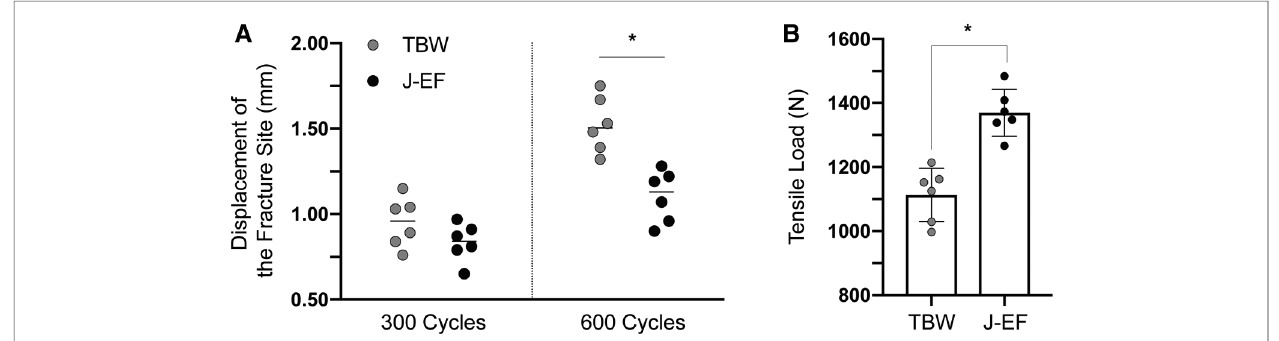
FIGURE 2 | Biomechanical properties of J-EF. Tensile strength of J-EF was tested using tension-band wiring (TBW) as the control. The tensile strength of the J-EF group was greater than that of the TBW group after running 600 cycles ( P <0.05). Similar results were found in the static tensile loading test between TBW and J-EF. The difference between the two groups was analyzed by Student ’ s t -test.